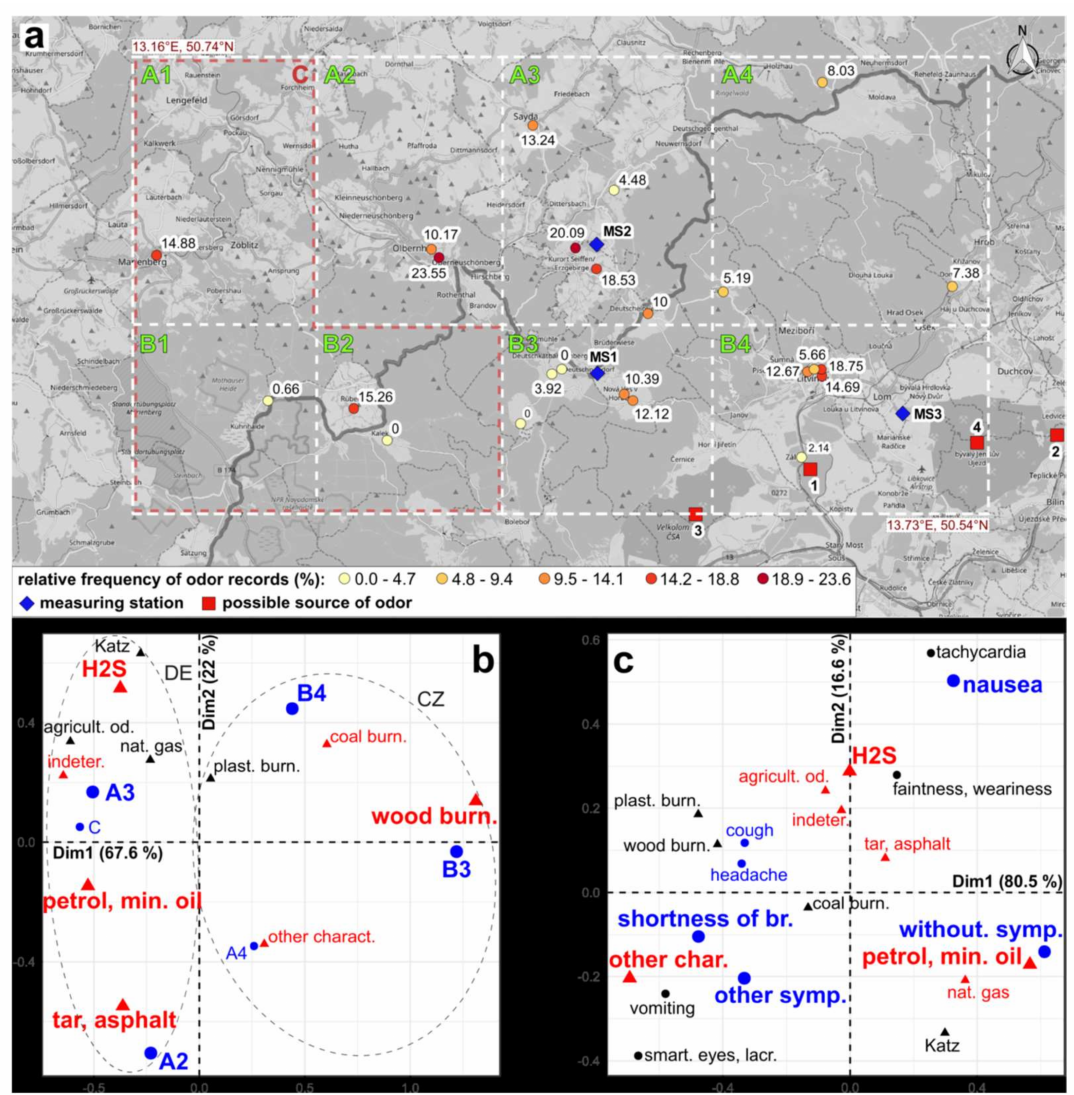
Figure 2. ( a ) Geographical distribution of study participants together with relative frequency of odor records (%). Measuring station: MS1–Deutschneudorf, MS2–Schwartenberg, MS3–Lom. Possible source of odor: 1–Unipetrol, 2–coal-fired power station Ledvice, 3—open pit mine ˇCSA, 4—open pit mine B í lina. There are drawn spatial segments (A1, . . . , A4, B1, . . . , B4, C = A1 + B1 + B2) of investigated area in the map, too. (Source of background map: https://openstreetmap.cz, accessed on 5 December 2021 14:10); ( b ) CA biplots: association between odor characteristics and spatial segments of study area; ( c ) CA biplots: association between odor characteristics and physical symptoms. Active elements are displayed in color; supplementary elements are displayed in